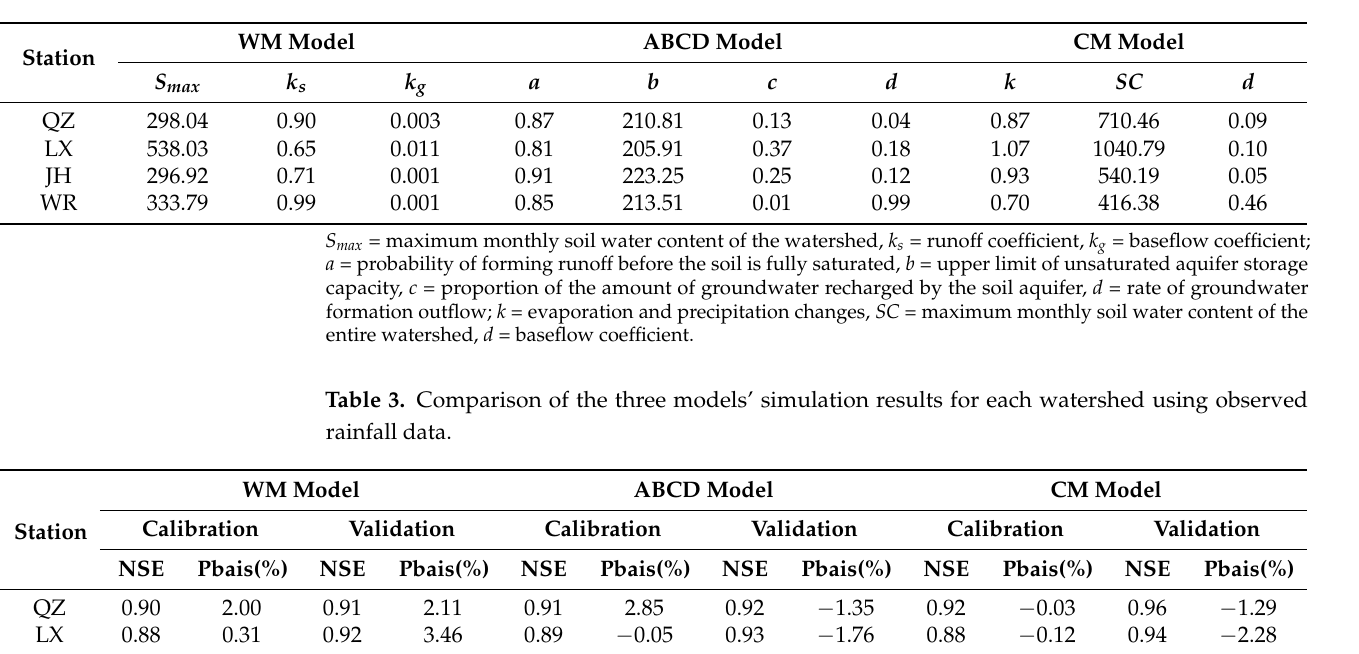
Table 2. Parameter values of three models for each watershed.